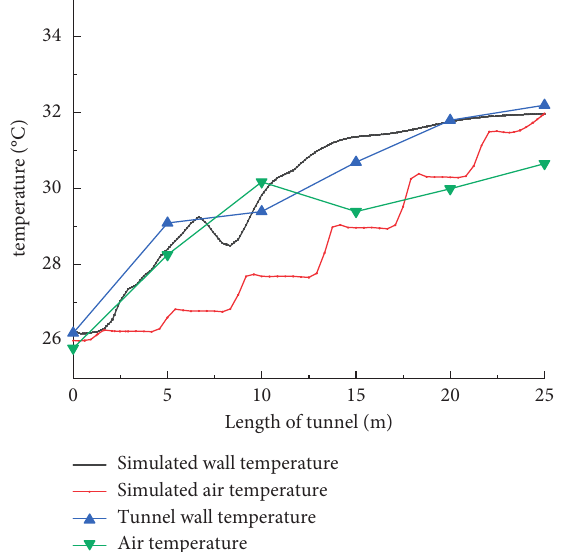
Figure 5: Comparison of simulated and measured temperatures.